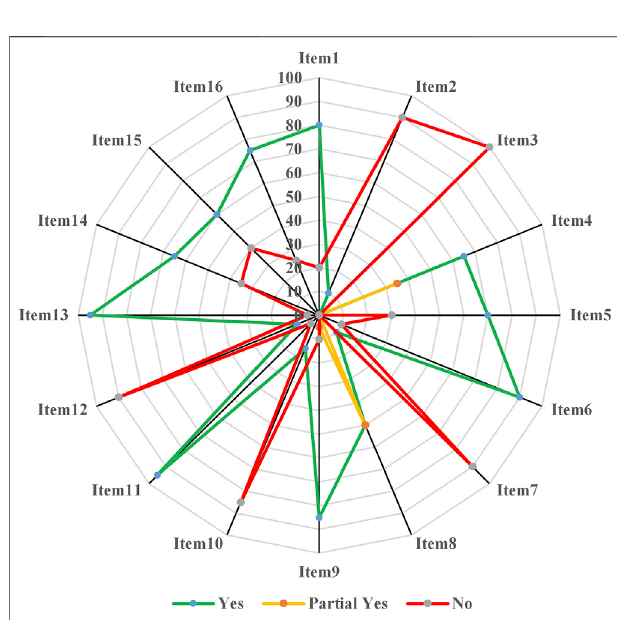
FIGURE 3 | Methodological quality based on the AMSTAR-2